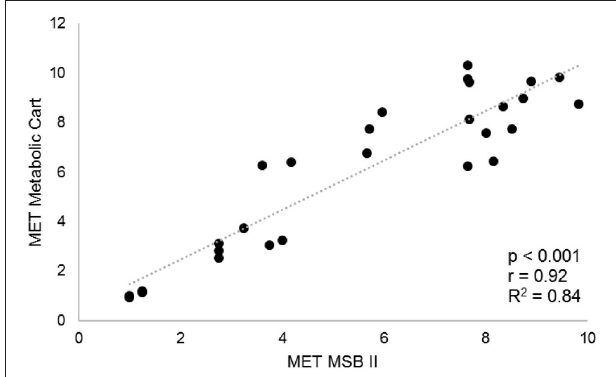
TABLE 1 | Summary of daily activity of 11 rowers during their preparation period.